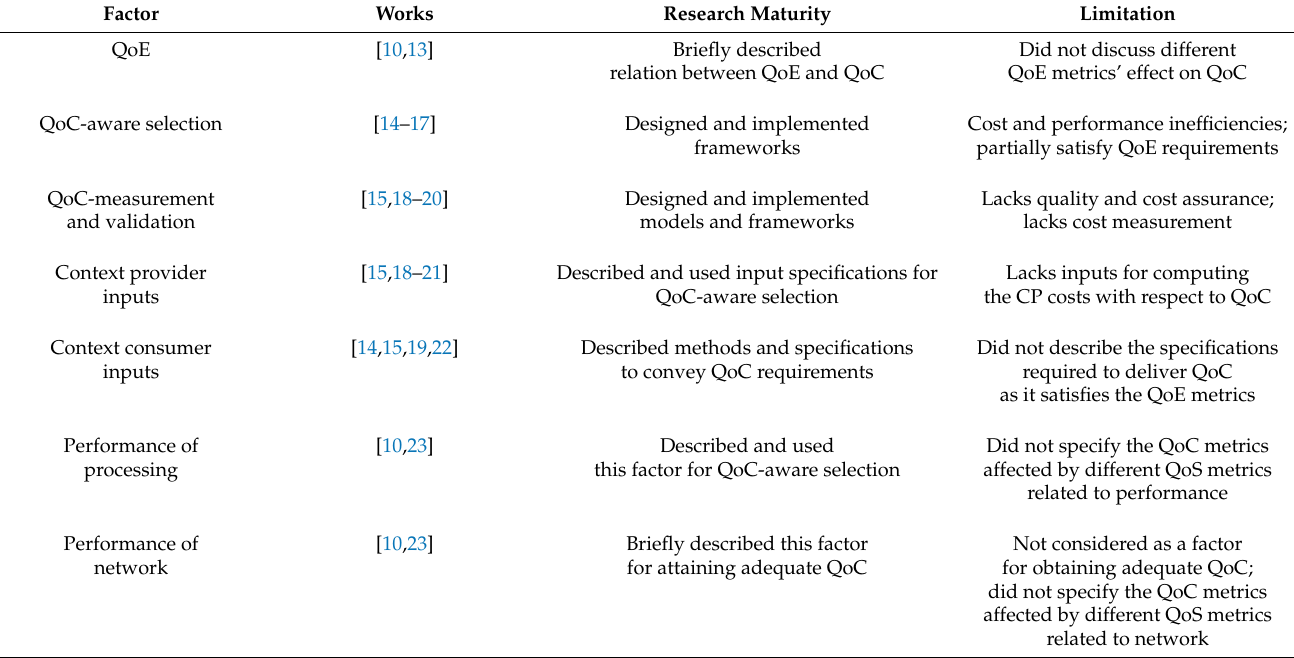
Table 1. Works discussing the factors represented in Figure 1, research maturity of these factors and